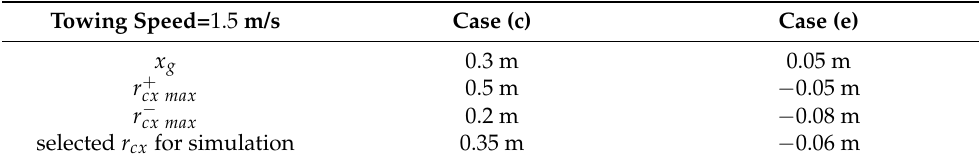
Table 4. Values of r + cx max and r − cx max according to x g when the towing speed is 1.5 m/s and selected r cx for